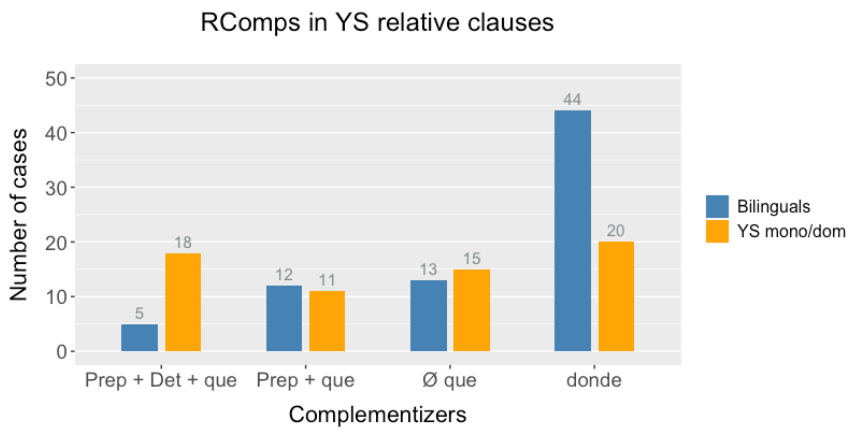
Figure 4. Results for relative complementizers in the relative clause data.